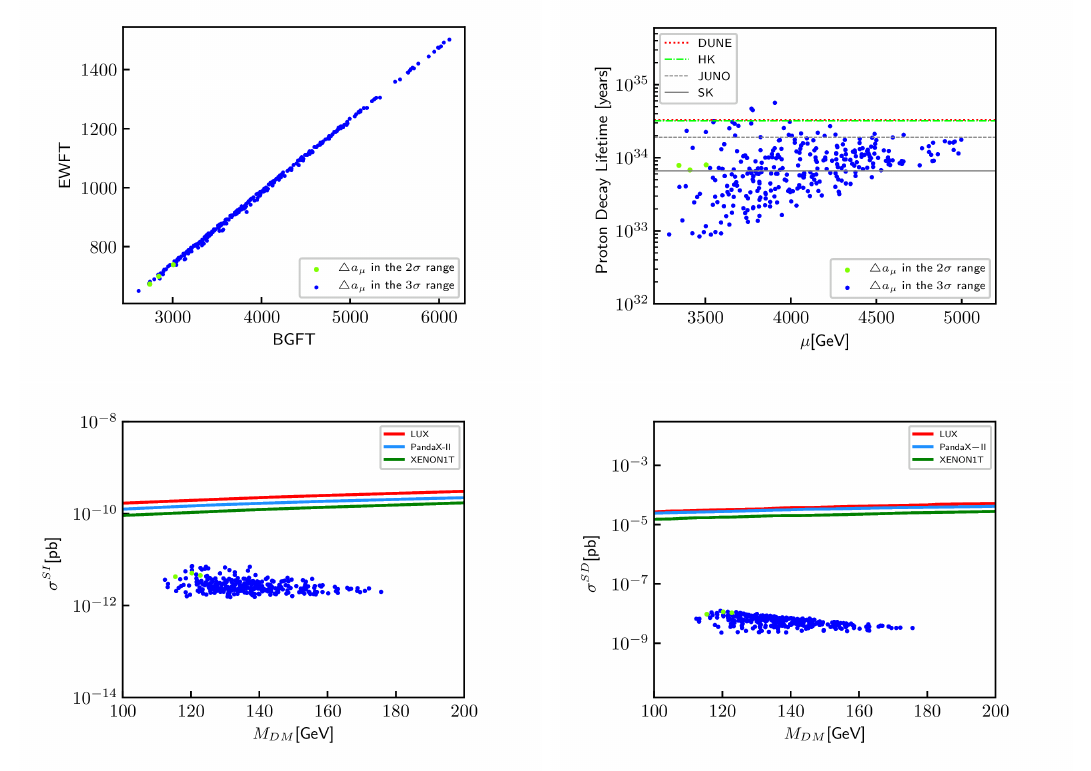
Figure 5 . Same as figure 3, but for scenario (2) with the wino dark